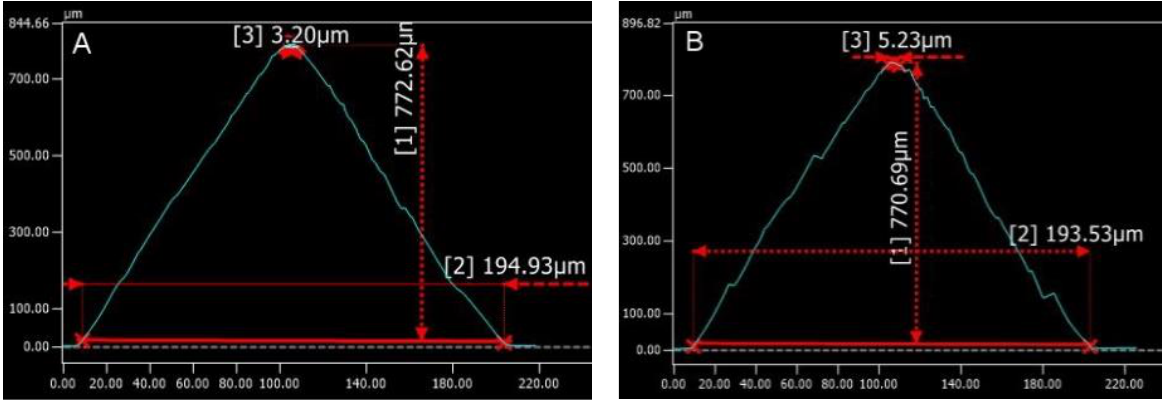
Figure 5. Keyence imaging results for ( A ) 4% amphotericin-B-loaded Gantrez TM microneedles and ( B ) 8% amphotericin-B-loaded Gantrez TM microneedles. The red lines represent measurements of the microneedle dimensions. Measurement [1] represents microneedle height, measurement [2] represents the microneedle base diameter, and measurement [3] represents microneedle tip diameter.